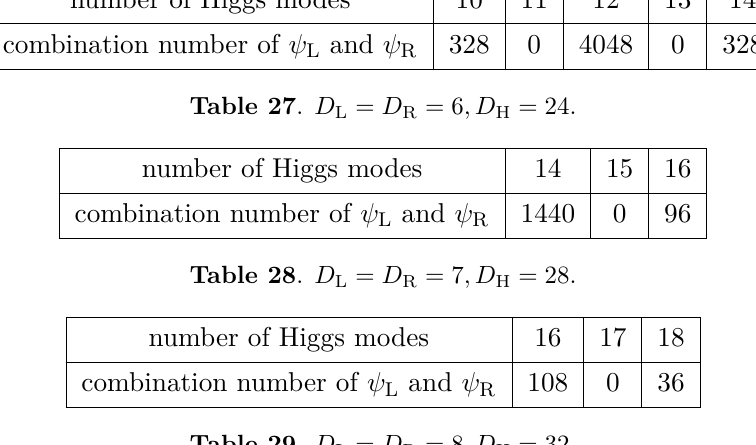
Table 29 . D L = D R = 8 , D H = 32